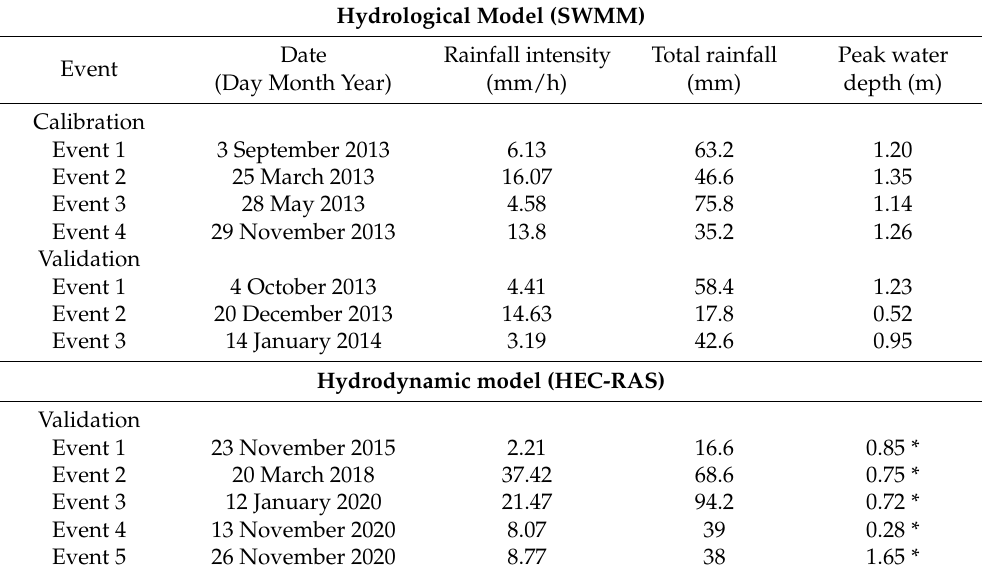
Table 2. Rainfall events and the resulting water depth peak used for calibration and validation of the hydrological and hydrodynamic